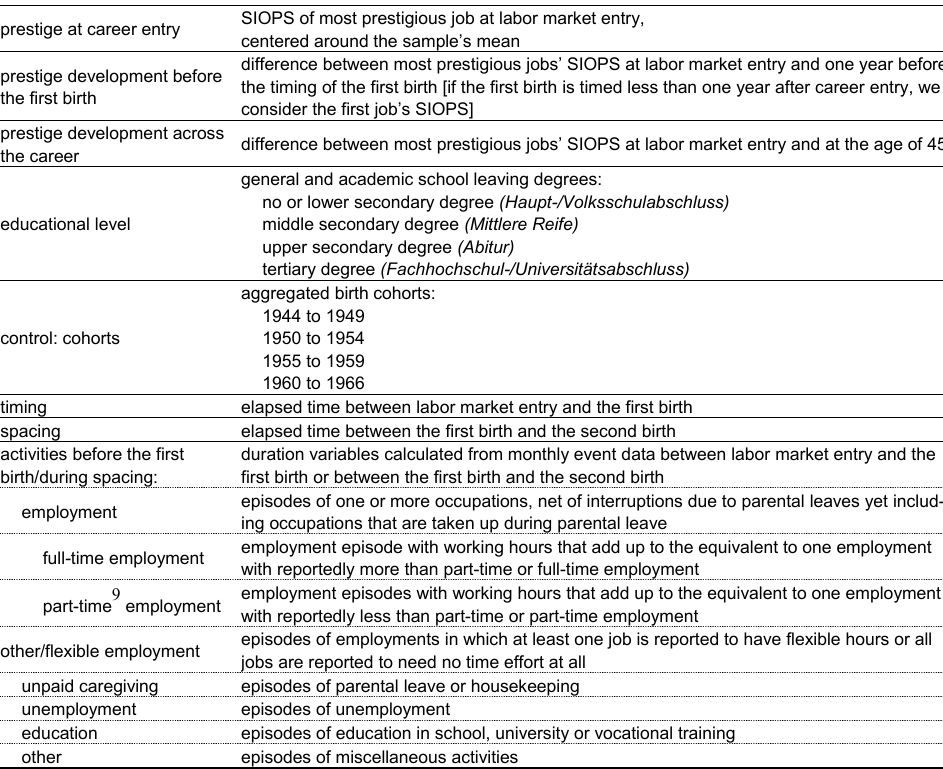
Table 1 : operationalization of relevant variables to women’s career development prestige at career